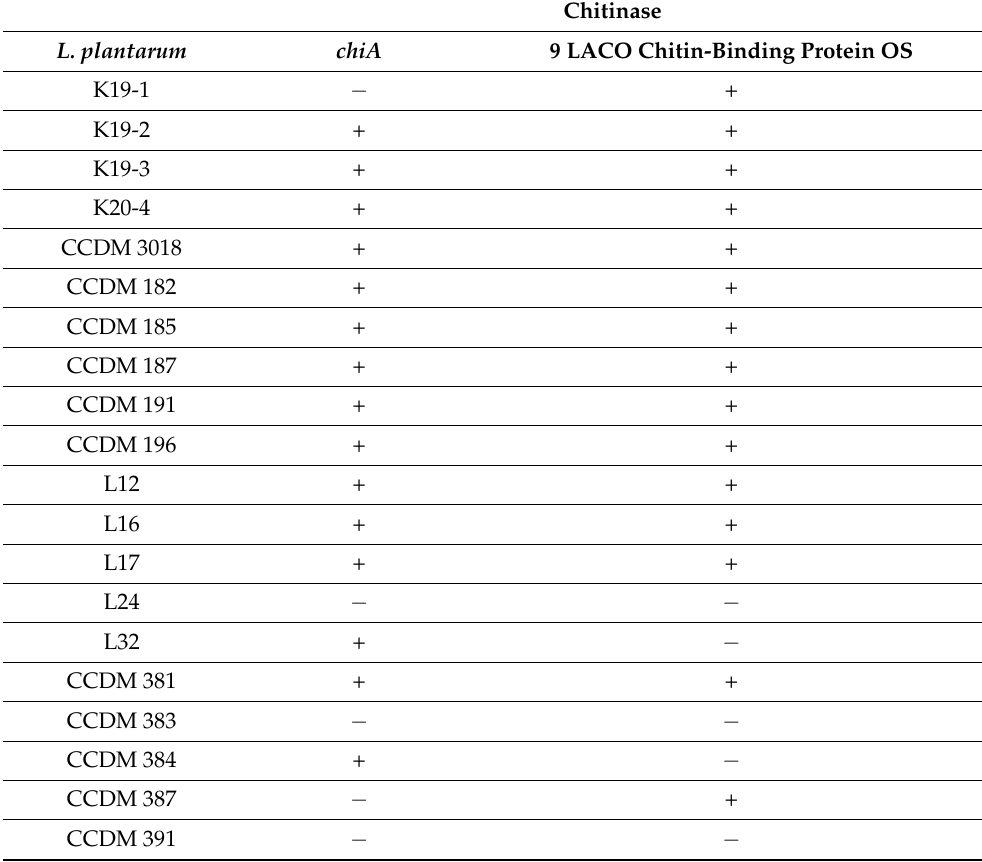
Table 6. The presence of chitinase chiA in DNA of tested L. plantarum strains. Presence of 9